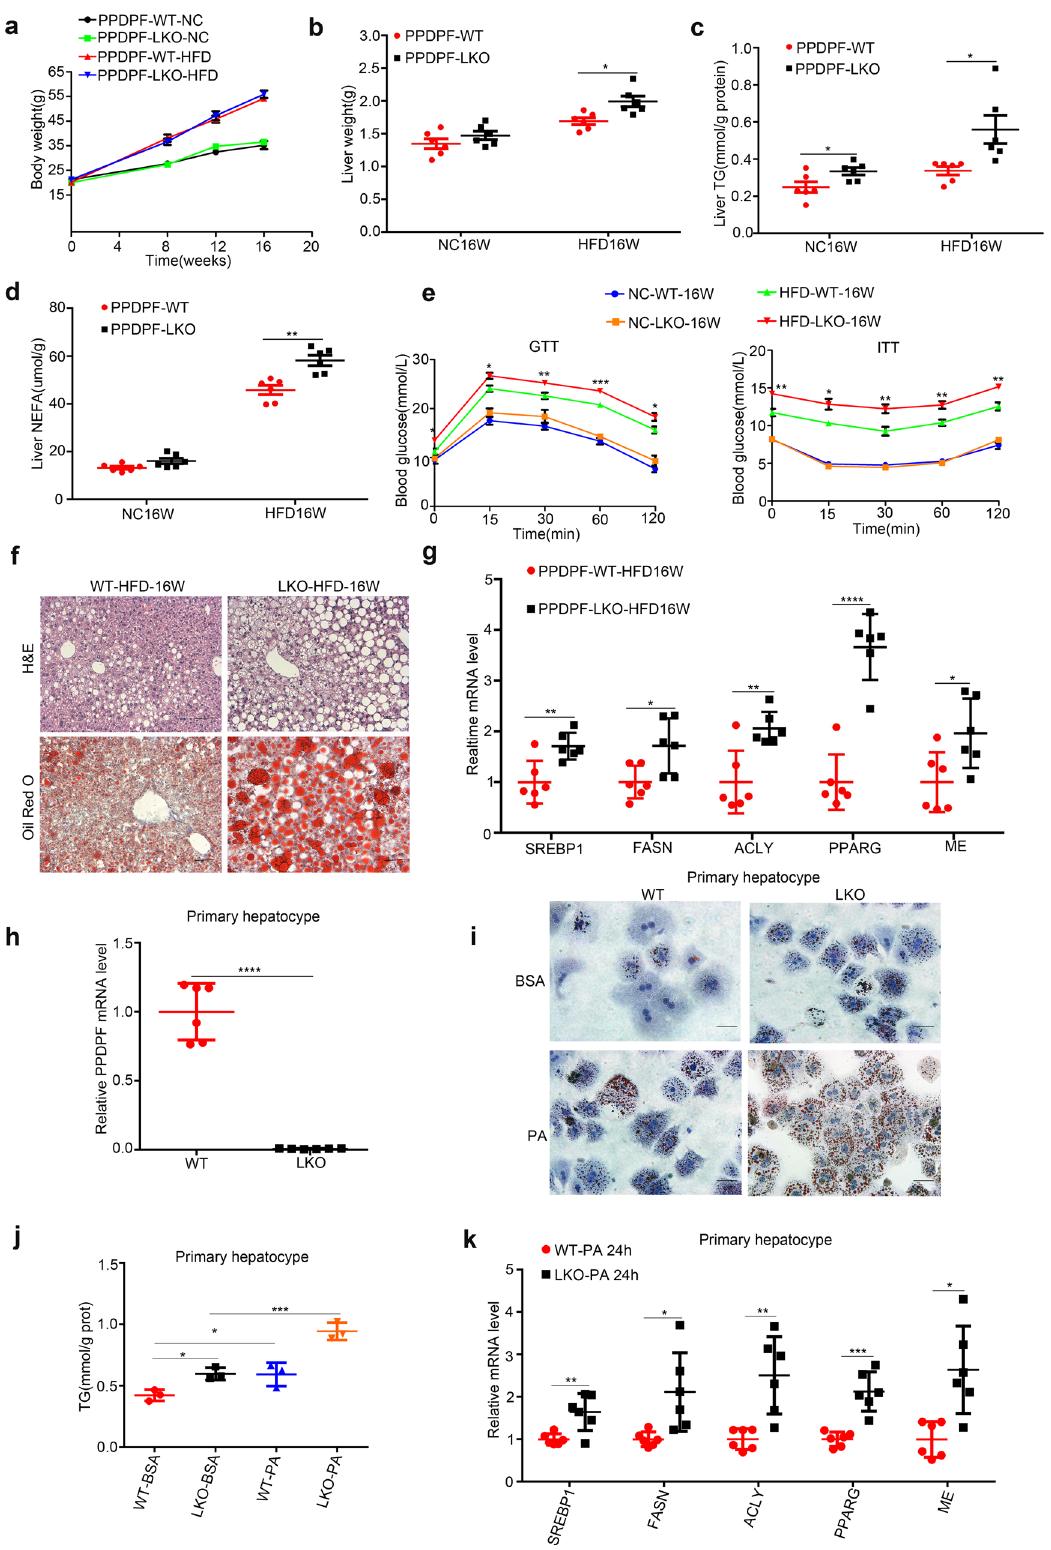
Fig. 3, AAV8-TBG-PPDPF dramatically reduced body weight (Supplementary Fig. 7a), liver weight (Supplementary Fig. 7b), hepatic TG (Fig. 6a), NEFA (Fig. 6b), lipid droplet accumulation (Fig. 6c), and the expression of lipogenic genes (Supplementary Fig. 7c) at 8 months. In contrast, AAV8-TBG-PPDPF mut did